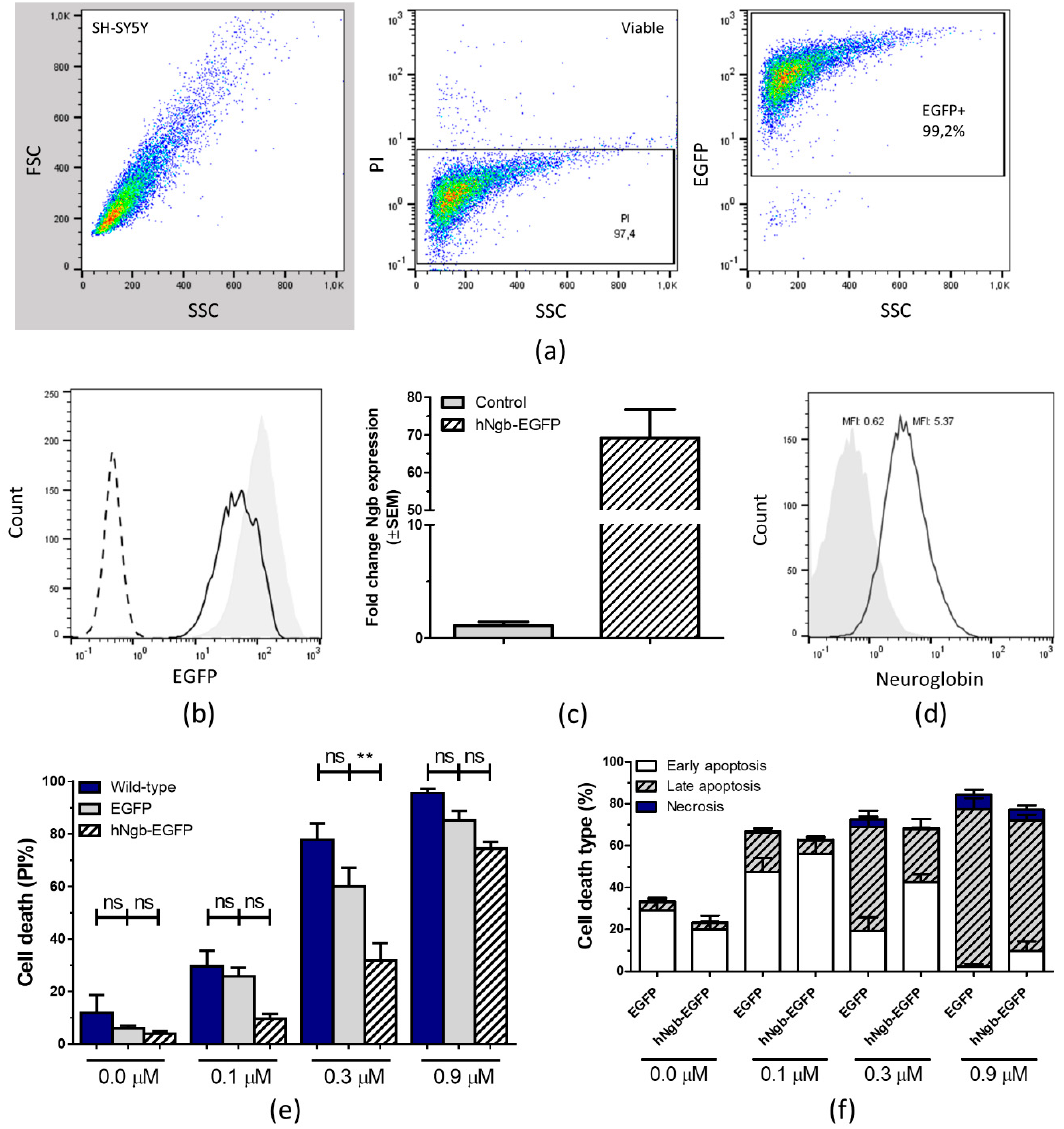
Figure 1. Human neuroglobin (hNgb)-EGFP SH-SY5Y cell line validation and anti-apoptotic characteristics. ( a ) Gating strategy for flow cytometric analysis. Initial gating was performed on propidium iodide (PI) and side scatter (SSC) plot, eliminating dead cells. Within the viable cell gate, EGFP + (or Cy3 + ) signals were identified. ( b ) Representative histogram profiles of EGFP-positivity in the wild-type (0% EGFP + , dashed line), EGFP control (99.2% EGFP + , gray shaded), and hNgb-EGFP (99.6% EGFP + , black line) SH-SY5Y cell lines, as determined from the gated viable fraction (PI-negative cells). ( c ) Bar graphs illustrate hNgb transcript levels in unstressed control and hNgb-EGFP SH-SY5Y cells (n = 4), as normalized to the global mean. ( d ) Histogram overlays show a representative example of the mean fluorescent intensity (MFI) after intracellular staining of hNgb in SH-SY5Y cells, transfected with EGFP (gray shaded, MFI 0.62) or hNgb-EGFP (black line, MFI 5.37). ( e / f ) Flow-cytometric data of SH-SY5Y cells subjected to 24 h of staurosporine-induced cell death (n = 5–6). Data are depicted as the mean ± SEM. ( e ) Total percentage of dead cells, as indicated by PI-positivity. Statistical significance was tested using one-way ANOVA with Bonferroni’s multiple comparisons test; ** p < 0.01. ( f ) Subclassification of cell death, i.e., early apoptosis (annexin V +/ PI − ), late apoptosis (annexin V +/ PI + ), and necrosis (annexin V ‐ /PI+).